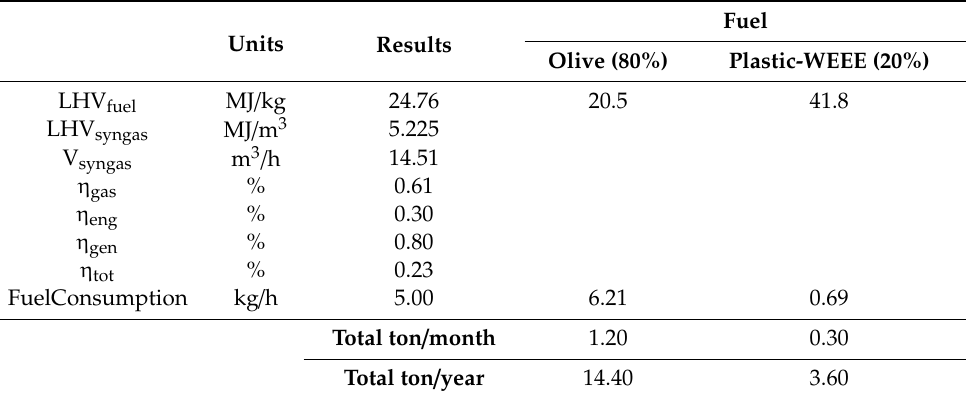
Table 14. Results for 80% olive and 20% plastic. (Source: